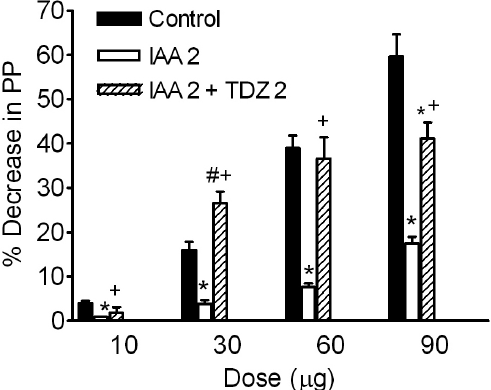
FIGURE 3 - Vasodilator effect of Alpinia zerumbet hydroalcoholic extracts obtained from in vitro cultures treated with different plant growth regulators on MVB pre-contracted with NE. *Value lower than control (MS0), # Value higher than control, + Higher response of IAA 2 + TDZ 2 treatment compared to IAA 2. Each point represents the average ± SE, n ≥ 6. Bonferroni, P <